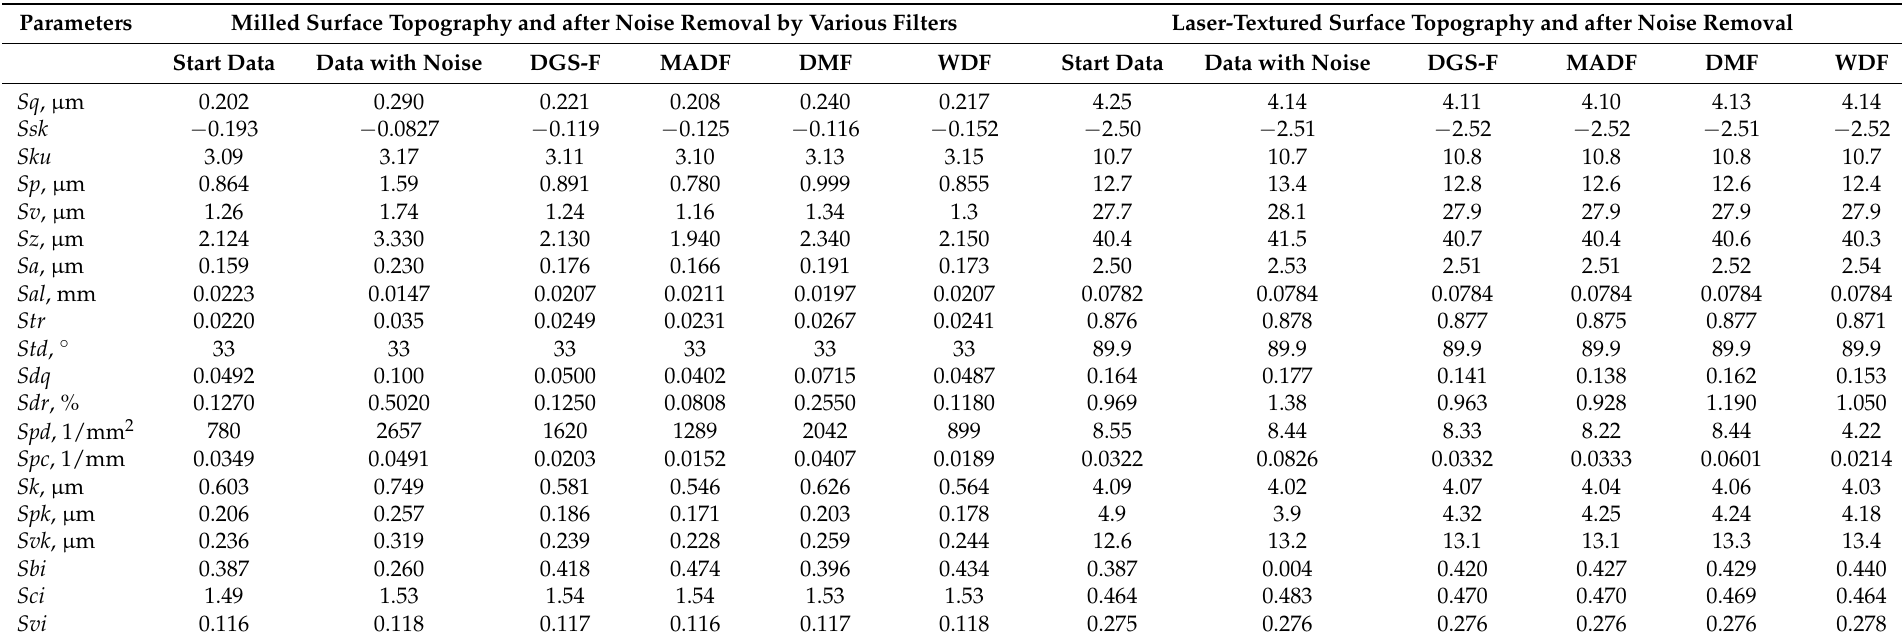
Table 5. Surface texture parameters calculated for milled (left part) and laser-textured (right part) surface before and after noise adding and reduction by different filters. Parameters Milled Surface Topography and after Noise Removal by Various